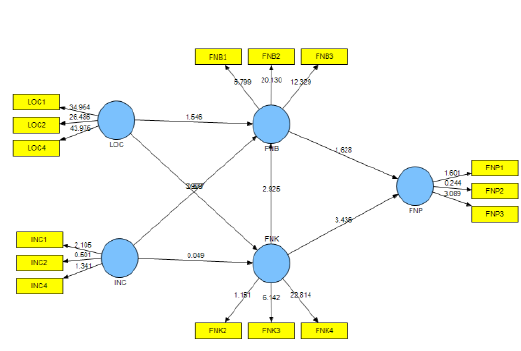
Figure 4. t-values of the Hypothetical